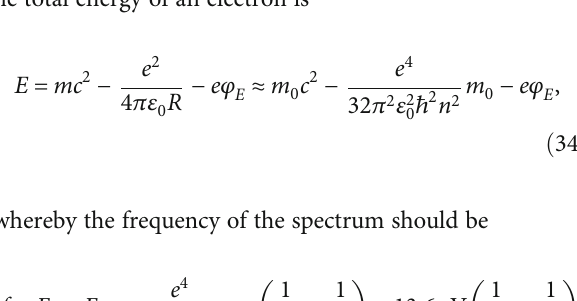
Figure 2: Schematic